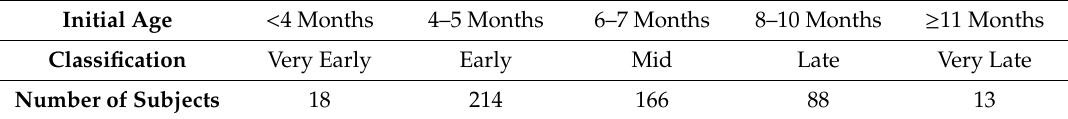
Table 2. Division of subjects based on treatment initiation age, corrected for prematurity ( n =